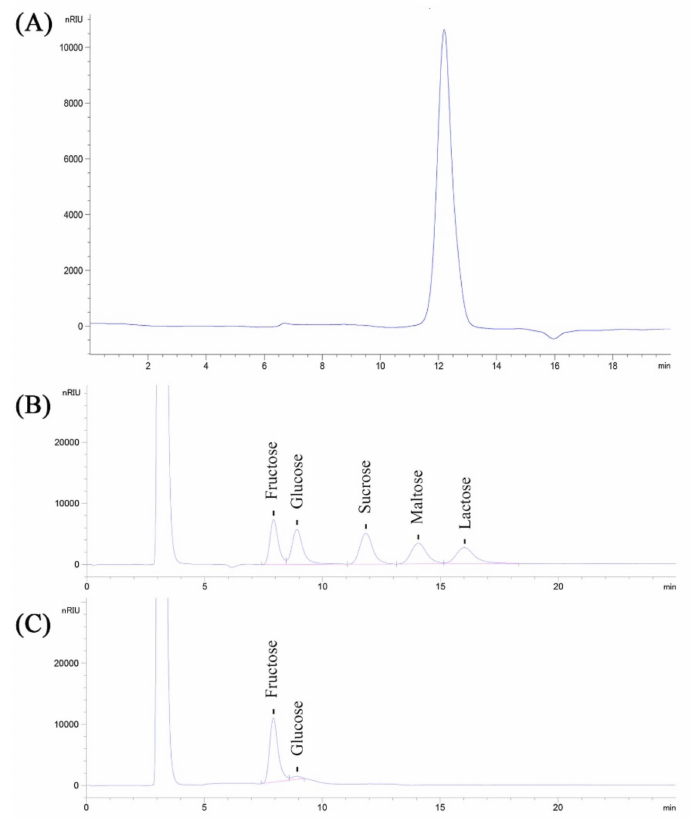
Figure 3. HPGPC ( A ) spectrum and HPLC analysis of standards ( B ) and CPPs ( C